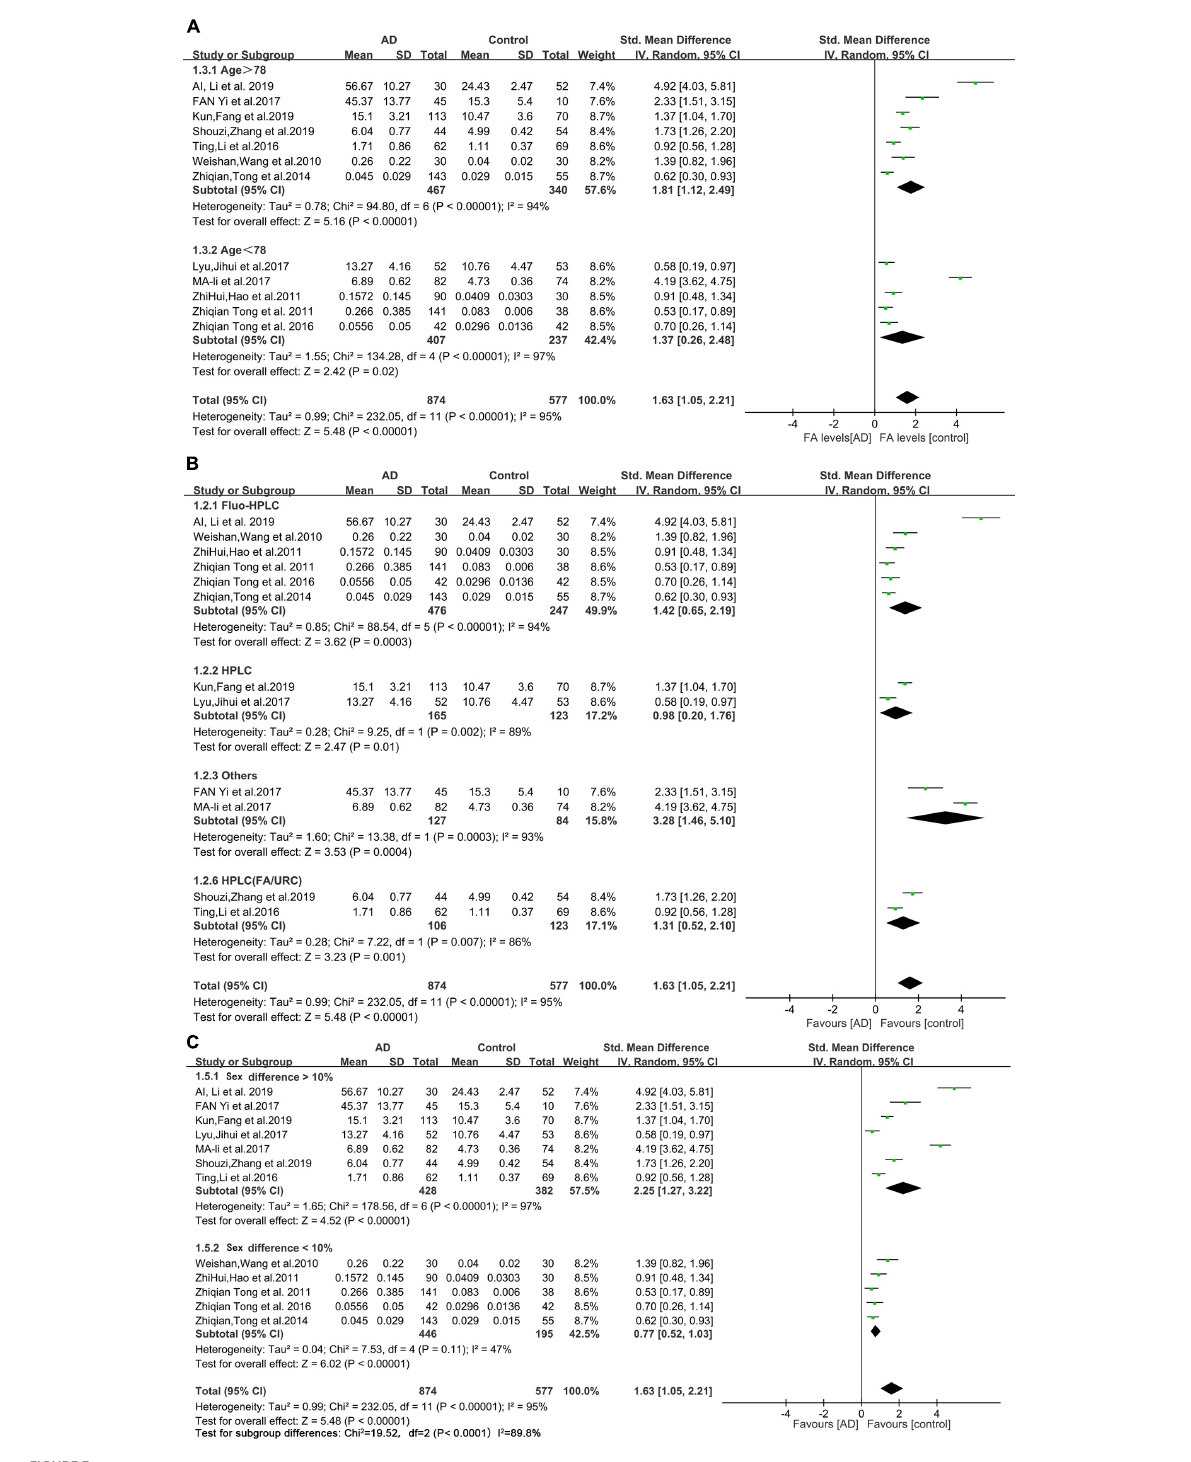
FIGURE3 Forest plot of subgroup analyses. (A) Results of a random-effects meta-analysis of urine FA levels in AD patients (Age > 78 or age < 78) and HCs ( p < 0.00001). (B) Random effects meta-analysis results of different detection methods for urine FA levels ( p < 0.00001). (C) Random effects meta-analysis results of urine FA levels in AD patients (sex difference > 10% or sex difference < 10%) and HCs ( p = 0.004). Diamonds represent combined effect estimates. The size of the green box is proportional to the weight assigned to each study, with horizontal lines representing 95% CI. AD, Alzheimer’s disease; SD, standard